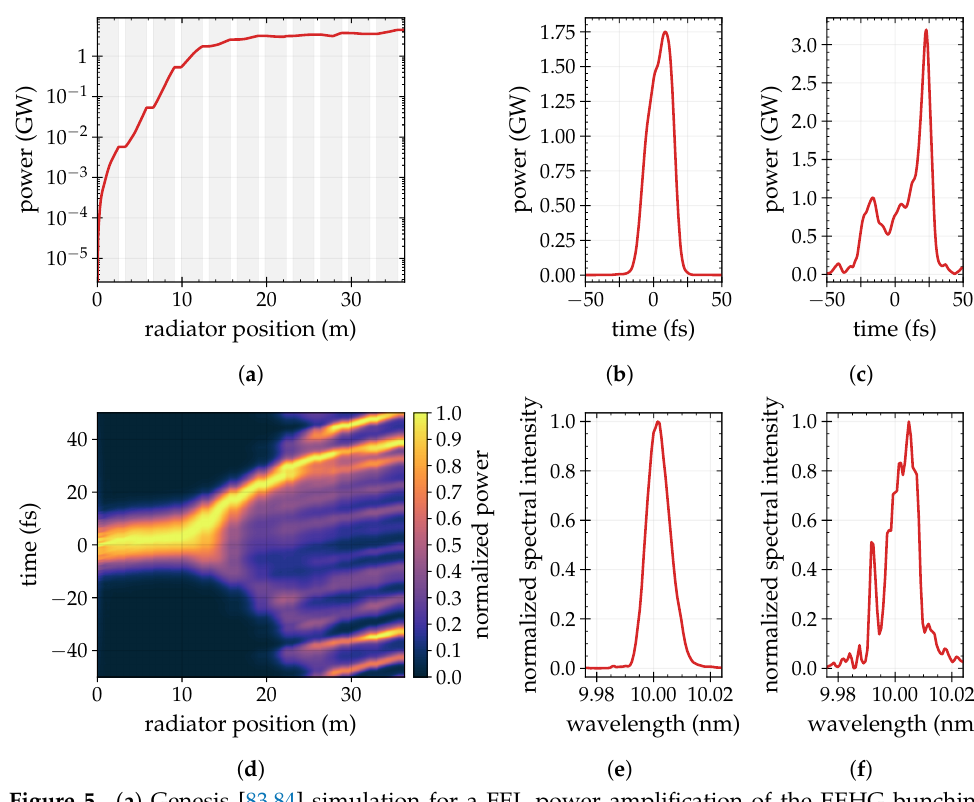
Figure 5. ( a ) Genesis [83,84] simulation for a FEL power amplification of the EEHG bunching in the FLASH1 radiator (grey and white areas represent active undulator and drift, respectively); ( b , c ) temporal and ( e , f ) spectral profiles of the FEL after the 4th and 6th radiator module, respectively. ( d ) Evolution of the FEL temporal profile (normalized) along the radiator